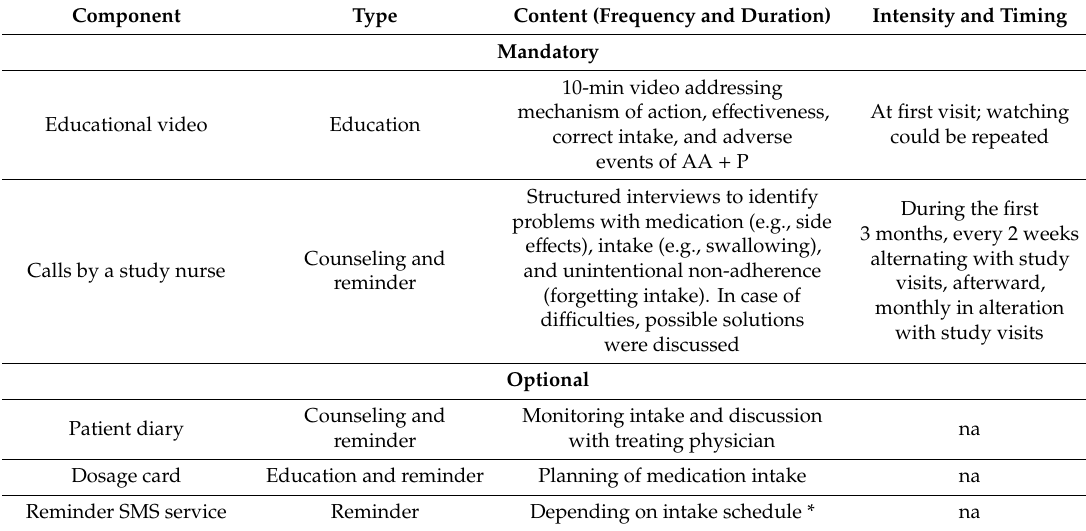
Table 1. Overview of the di ff erent adherence-enhancing